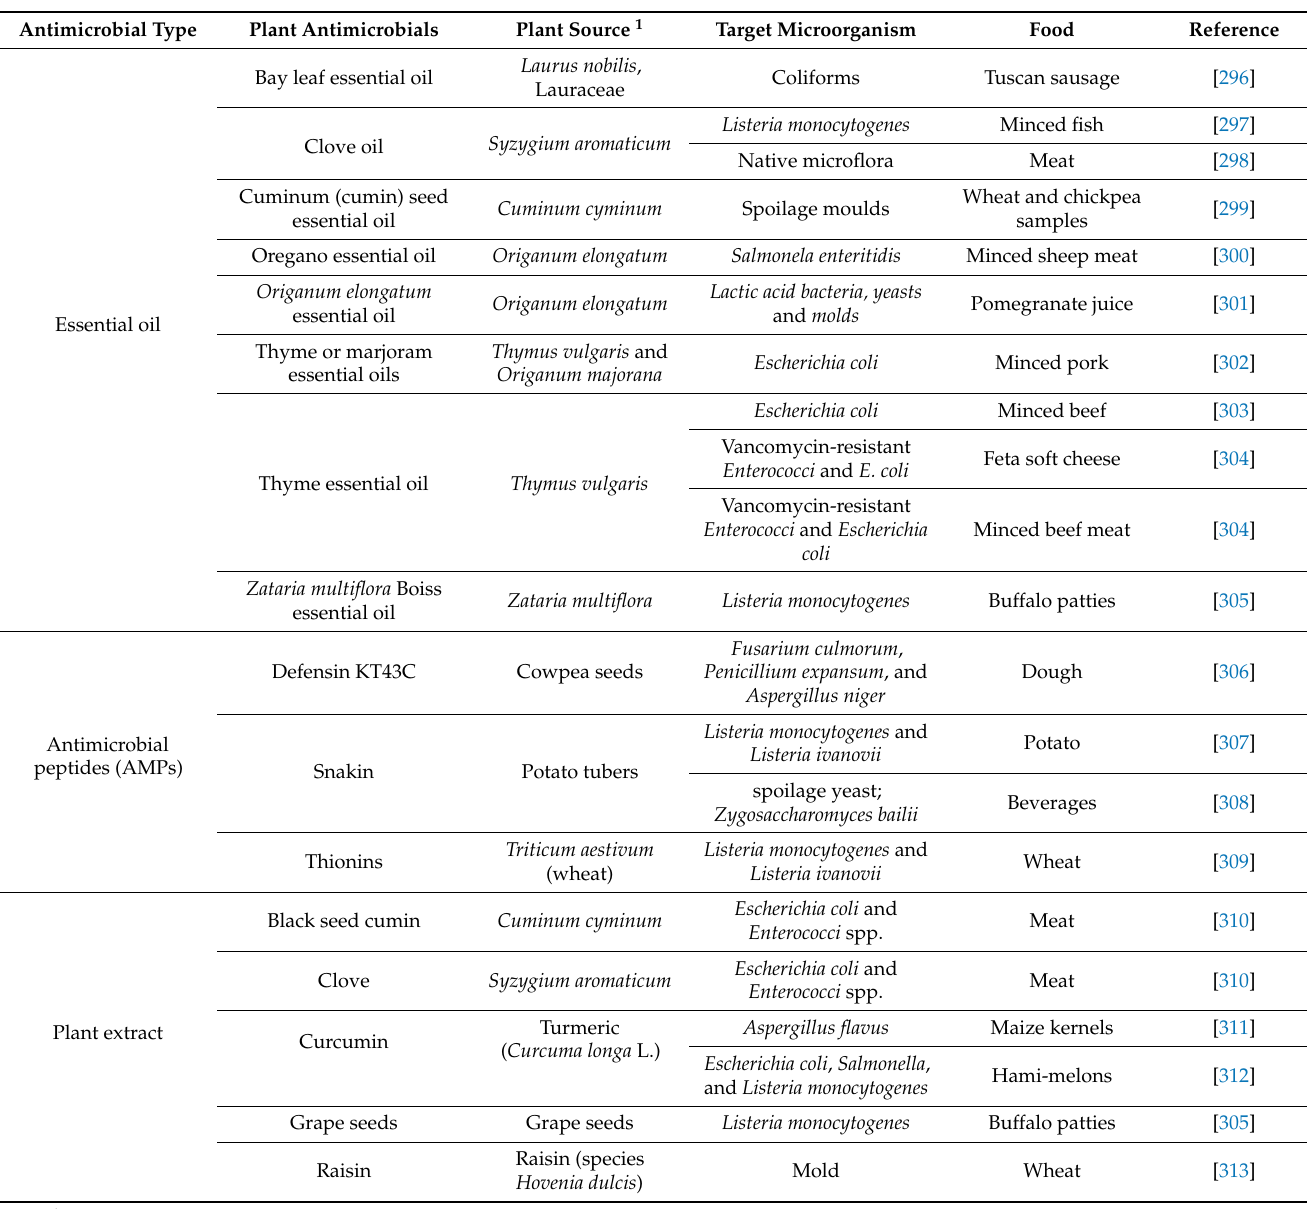
Table 4. Plant antimicrobials for food disinfection and